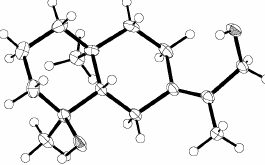
Figure 2. The crystal form of compound 1.